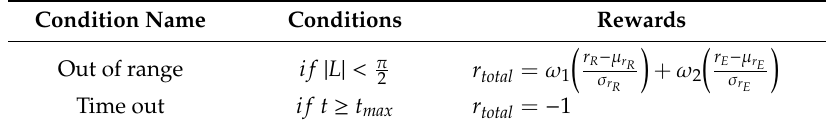
Table 2. Definition of conditions and transition rewards under corresponding